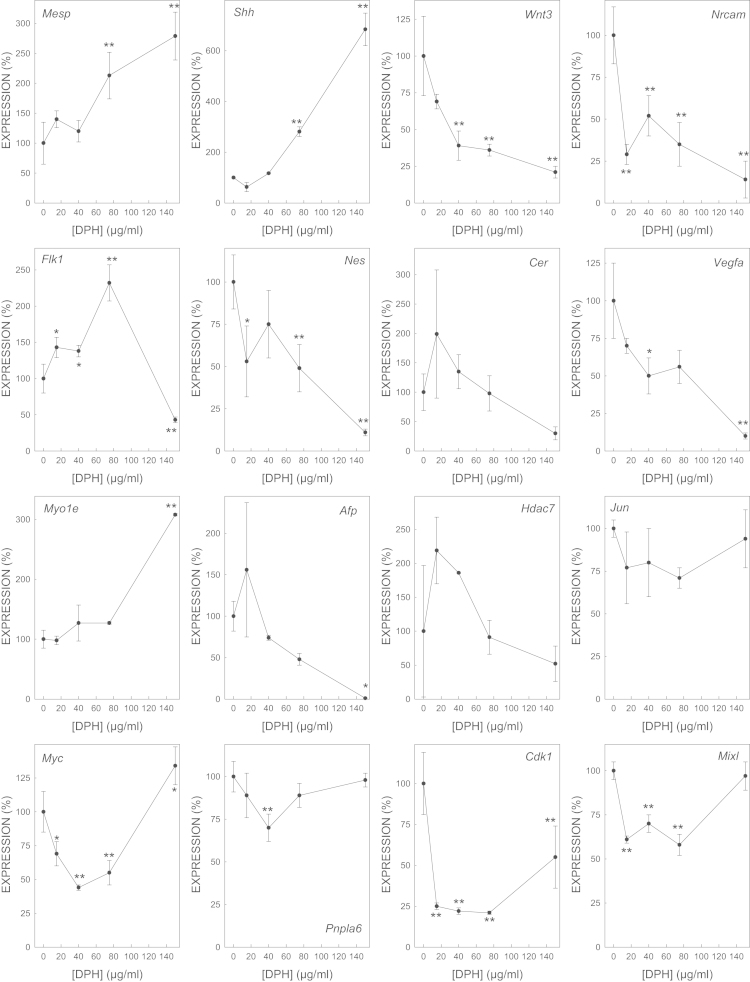
Effect of DPH on the expression of biomarker genes.